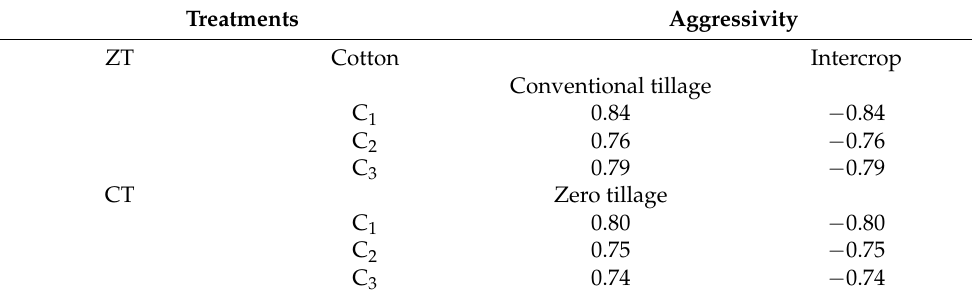
Table 4. Effect of different tillage systems and legume intercrops on the aggressivity of system productivity.